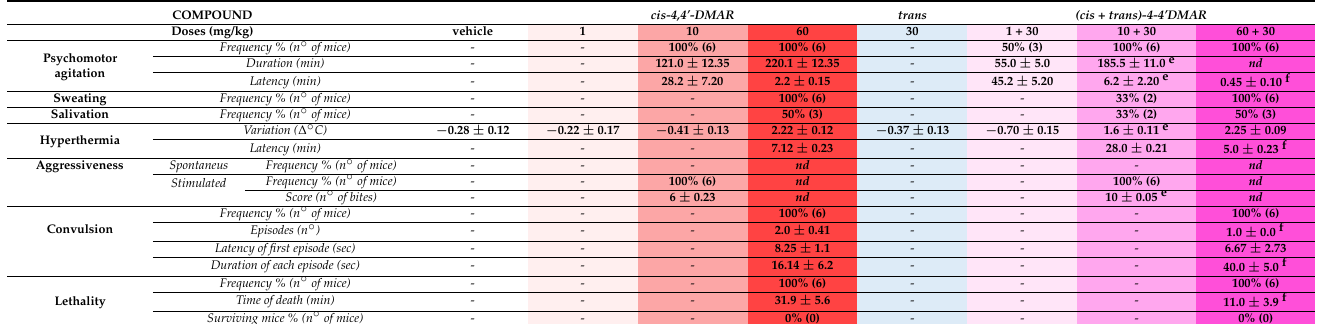
Table 3. Effect of co-administration of ( ± ) cis -4,4 (cid:48) -DMAR (1, 10 and 60 mg/kg i.p.) and ( ± ) trans -4,4 (cid:48) -DMAR (30 mg/kg i.p.) on neuro-behavioural changes (psychomotor agitation, aggressiveness, convulsion), physiological alterations (sweating, salivation, hyperthermia) and death in mice. Data expressed (see material and methods) represents the mean ± SEM of six animals for each treatment. The statistical analysis of the effects of the interactions between ( ± ) cis -4,4 (cid:48) -DMAR and ( ± ) trans -4,4 (cid:48) -DMAR were performed using a one-way ANOVA followed by a Bonferroni test for multiple comparisons. A Student’s t -test was used to determine statistical significance ( p < 0.05) between the two groups. e p < 0.05, versus cis 10 mg/kg; f p < 0.05, versus cis 60